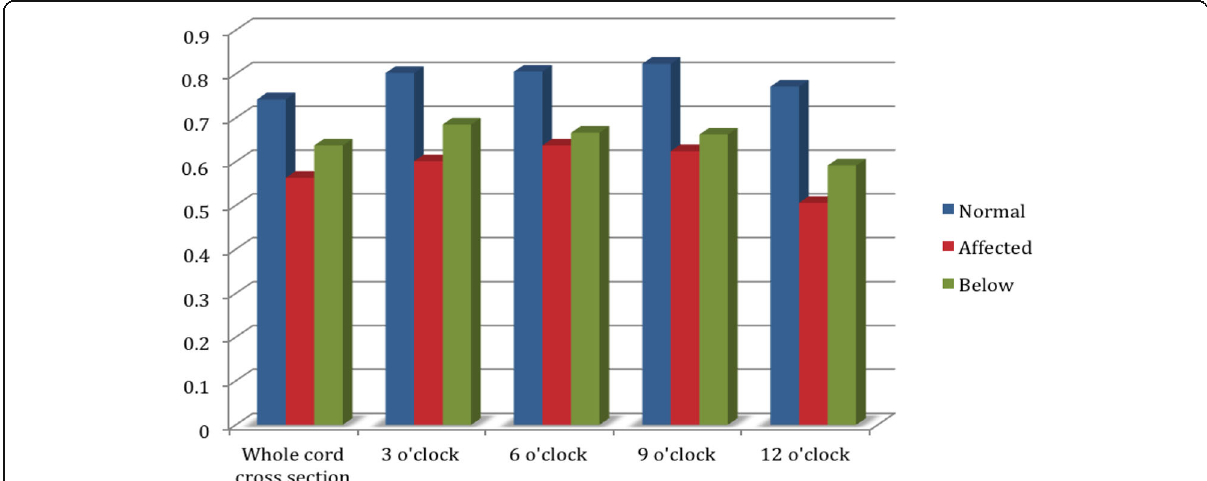
Fig. 2 Comparison between mean FA values classified according to normal cord, cord opposite most affected disc and cord below the most affected disc levels at different sites. The most significant reduction of FA value was found to be opposite the most affected disc level at 12 o ’ clock